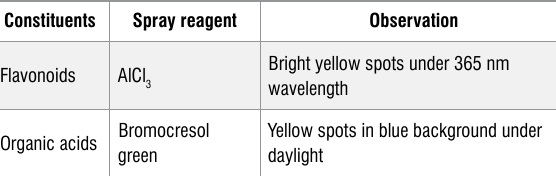
Phytochemical screening tests